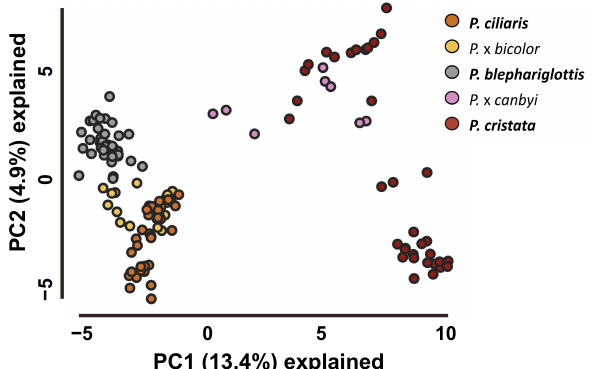
Figure 2. Principal Component Analysis of Platanthera taxa. PCA of SNP datasets reflected clustering of parent species based on their genomic